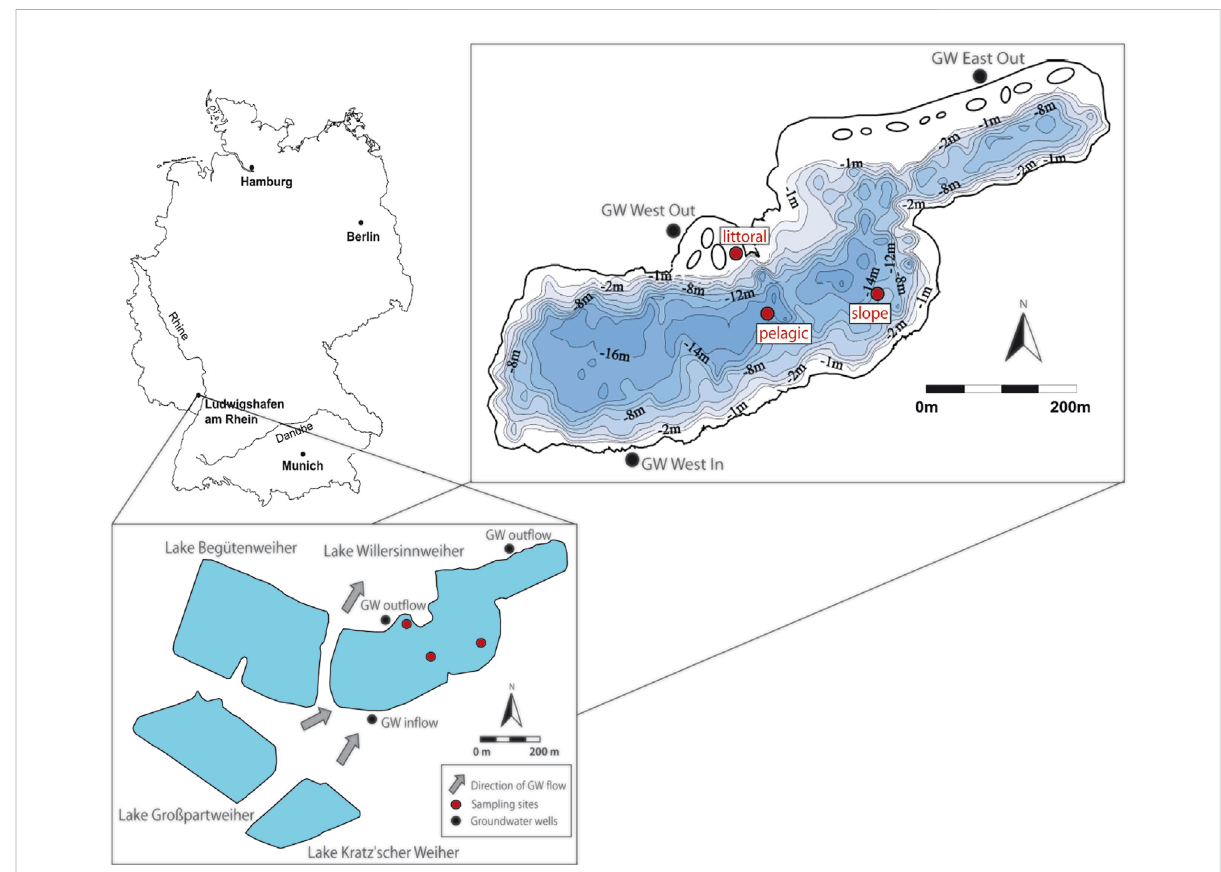
FIGURE 2 Location of Lake Willersinnweiher and the three adjacent lakes inGermany modi fi ed after Kleint etal. (2021). Lake sampling sites(pelagic, slope and littoral) and groundwater sampling sites (GW West In, GW West Out, GW East Out) are shown as red and black dots, respectively. Groundwater fl ow direction was modi fi ed after Wollschläger et al.